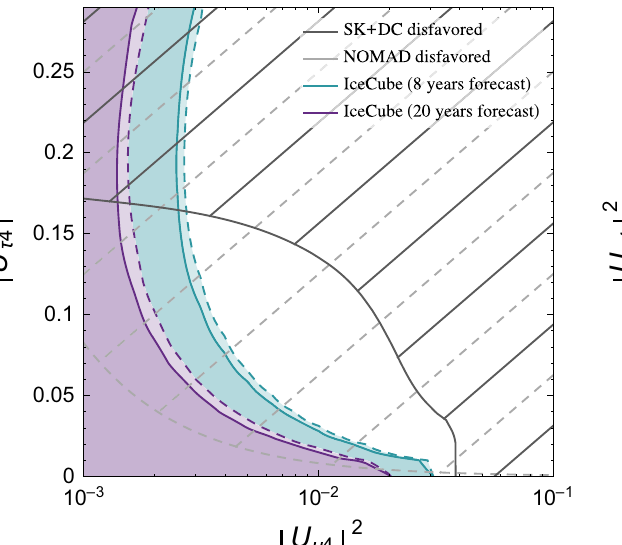
( δ 24 = π ). The solid (dashed) gray hatched regions are disfavored by Super-Kamiokande [40] and DeepCore [54] (NOMAD [56]) data at the same